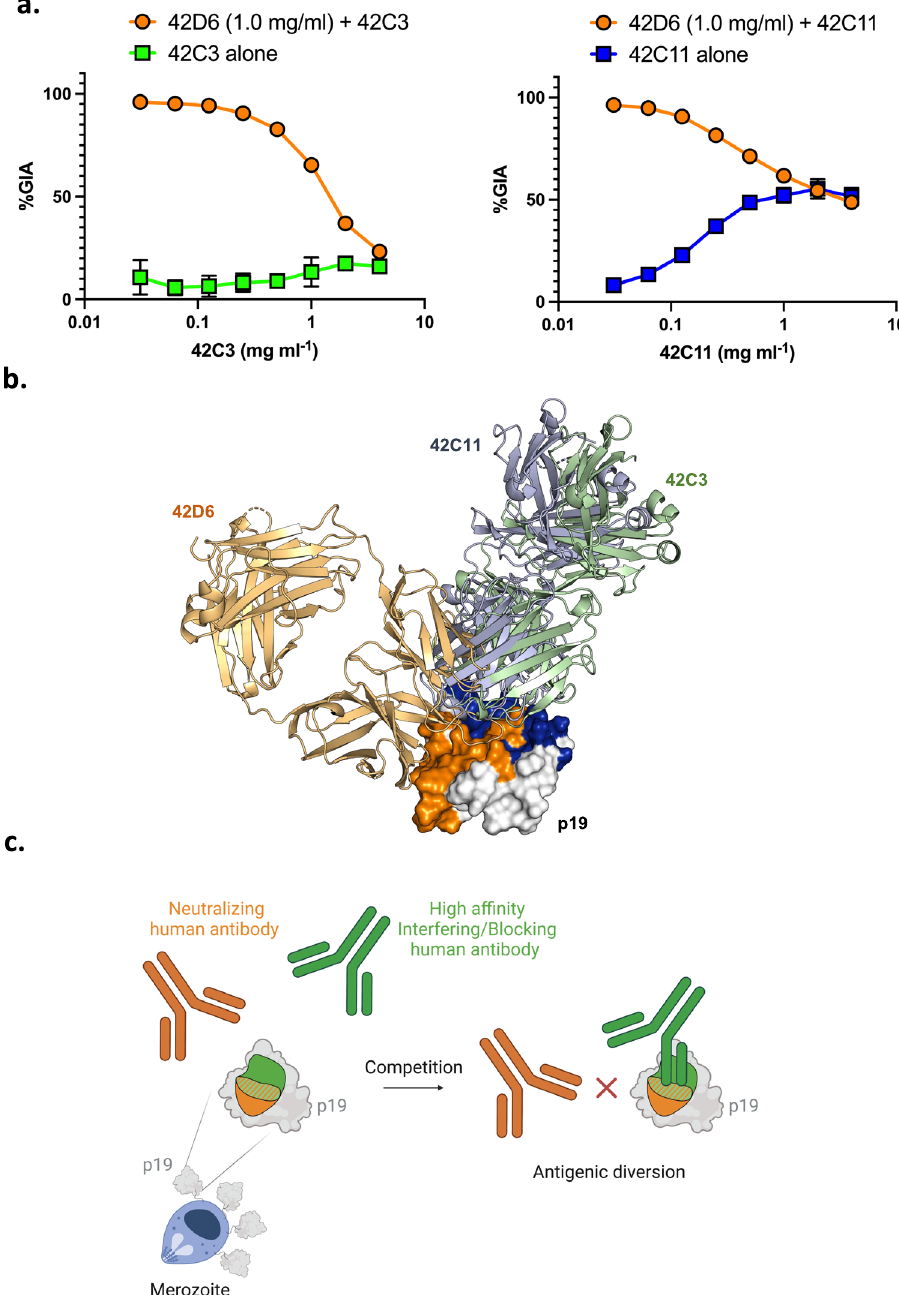
Fig. 4 | Structural basis of antigenic diversion. a GIA of neutralizing hmAb 42D6 (1.0mg/ml) in the presence of an increasing concentration of non-neutralizing hmAbs 42C3 and 42C11 that block its binding to p19. The data arise from three independent biological replicates and plotted as mean±standard deviation. Source data are provided as a Source data fi le. b Superposition of p19-Fab